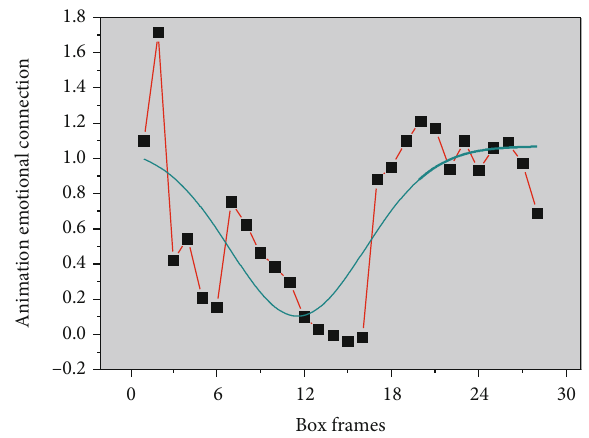
Figure 8: Animation emotional connection and box o ffi ce relationship.